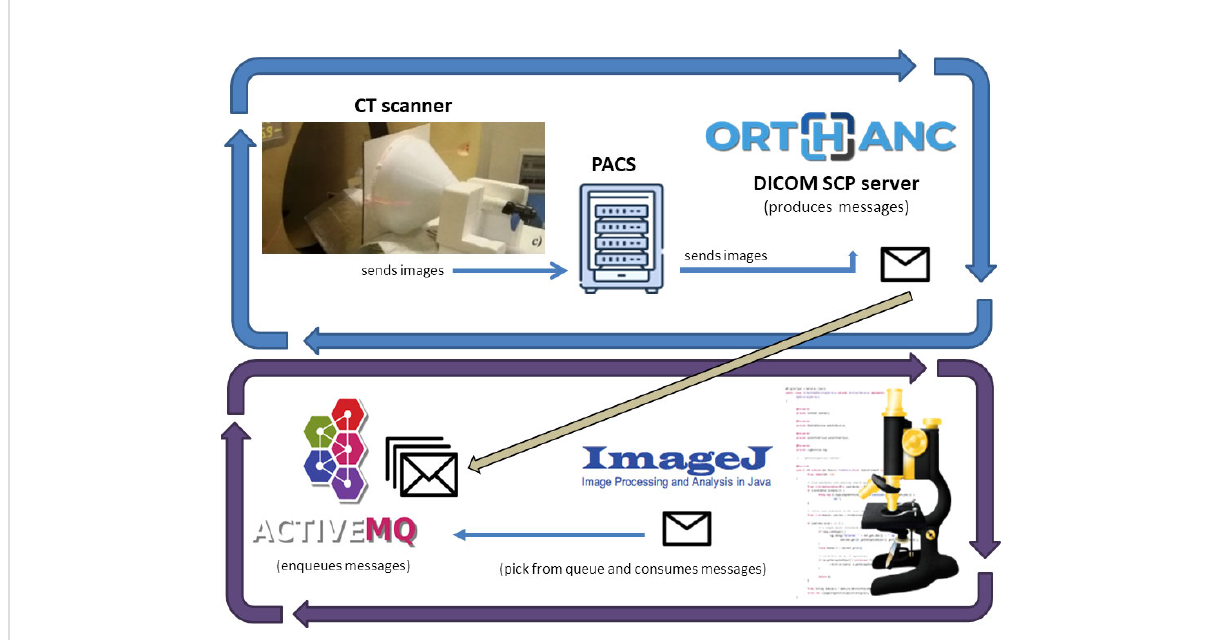
FIGURE 3 Software architecture of our system: Images received from the Institutional PACS archive are sent for storage to an Orthanc DICOM server. The server sends messages on an ActiveMQ queue using the Lua script. A Java software built on ImageJ API does D W and SSDE computations for every message it reads from the queue.